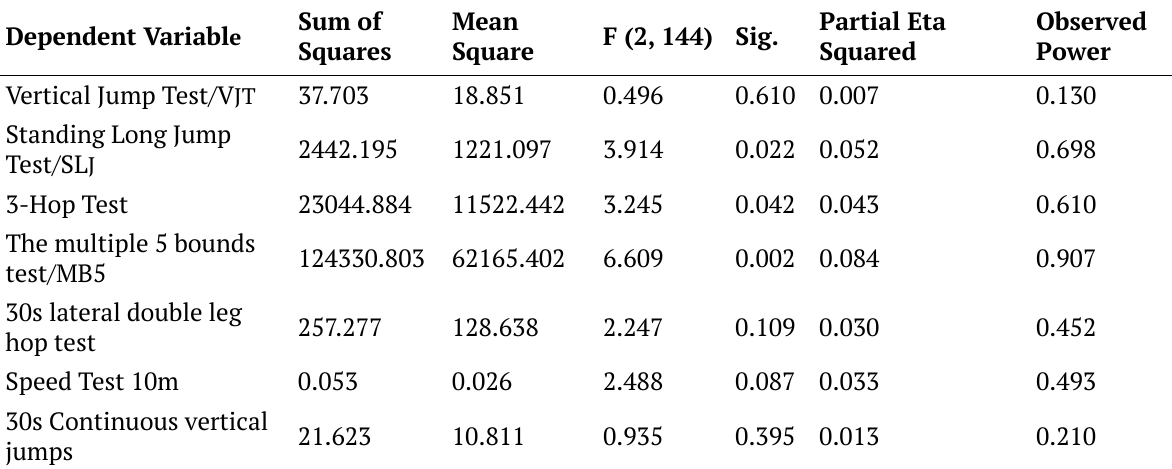
Table 3. Univariate test results (ANOVA) – The effect of variable BMI levels on the performances in lower body strength